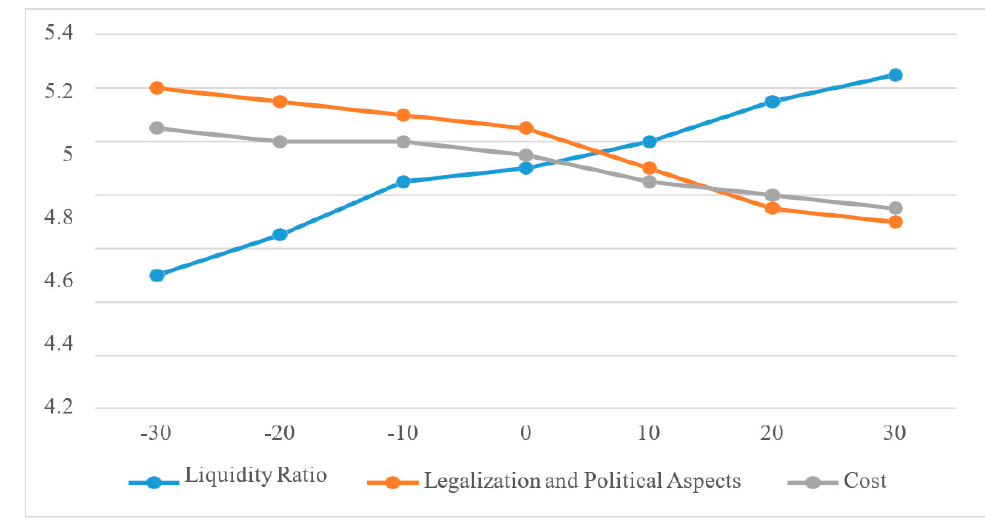
Figure 5. Output of the developed sensitivity analysis model.